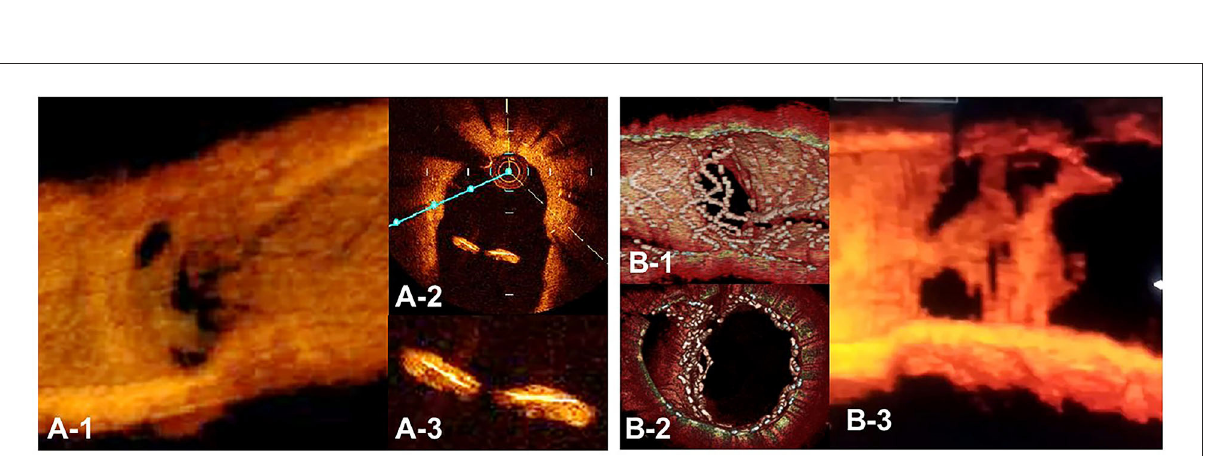
FIGURE12 Optical coherence tomography ( OCT) image of intimal proliferation on jailing struts at long-term follow-up period. A. One-year follow-up after crossover stenting with a synergy stent in the left anterior descending artery (LAD) without the fenestration of the diagonal branch. ( A-1) 3D vessel view shows complete intimal coverage on the stent struts even in the jailing struts on the diagonal branch ostium with some luminal narrowing. (A-2) 2D imaging on the bifurcated site. (A-3) magnified view of the jailing struts. Complete intimal coverage of all surfaces of the struts was completed. (B) 3D OCT image after culotte stenting in LAD and diagonal branch using resolute integrity stents with significant metallic carina formation remaining ( B-1 : immediately after stenting, perpendicular view, (B-2) view from proximal to the bifurcation). (B-3) Two-year follow-up. 3D OCT image shows intimal coverage along the struts of the metallic carina, with several holes remaining (Supplementary Movie